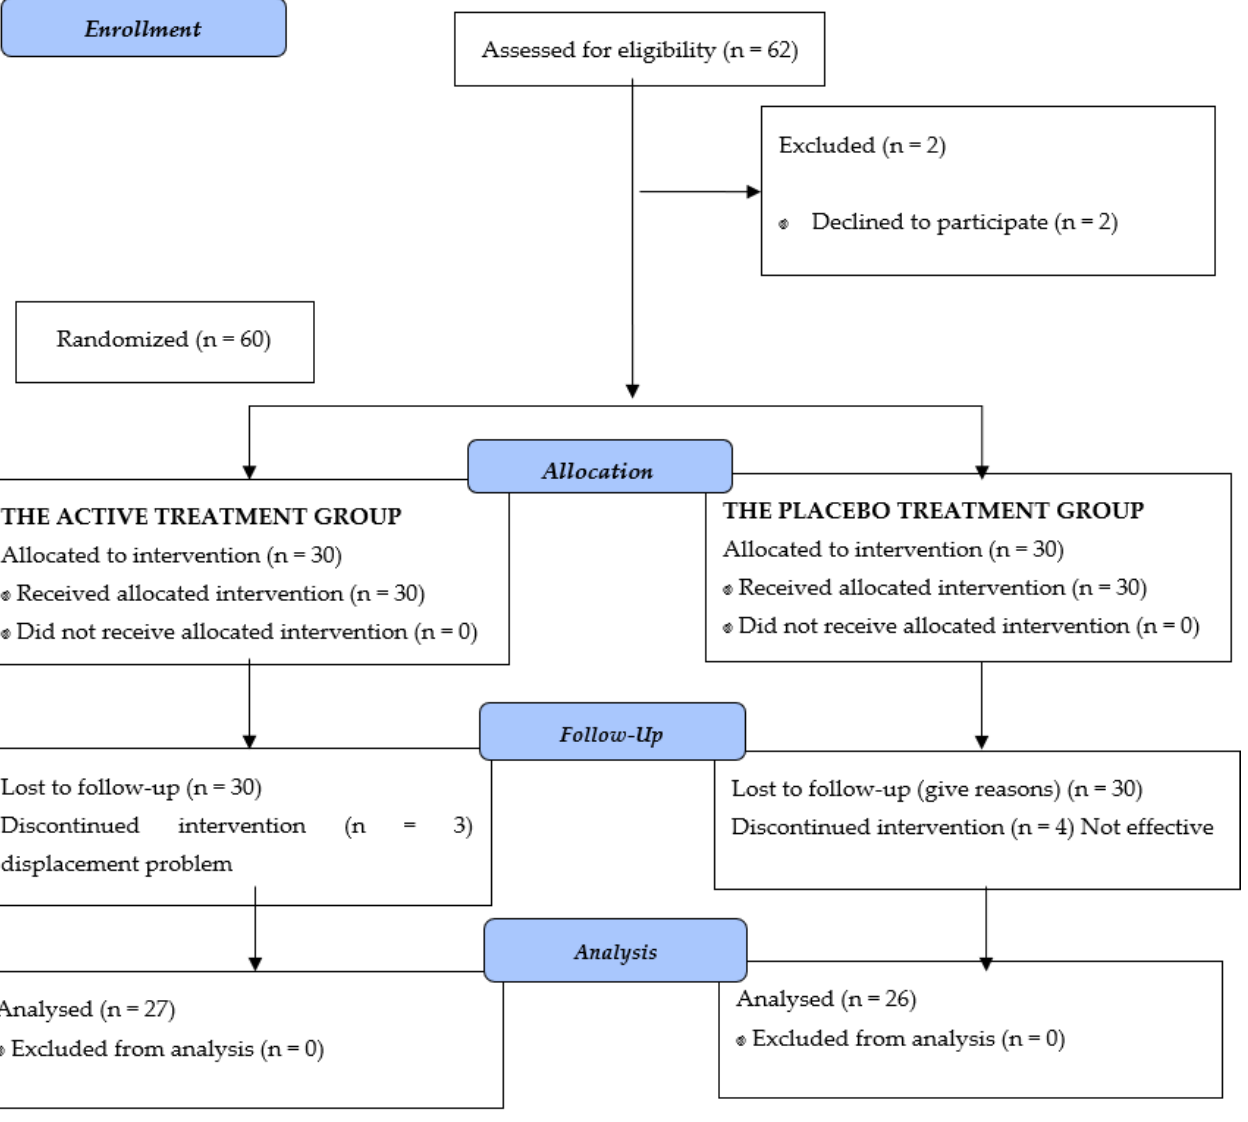
Figure 1. CONSORT 2010 Flow Diagram.